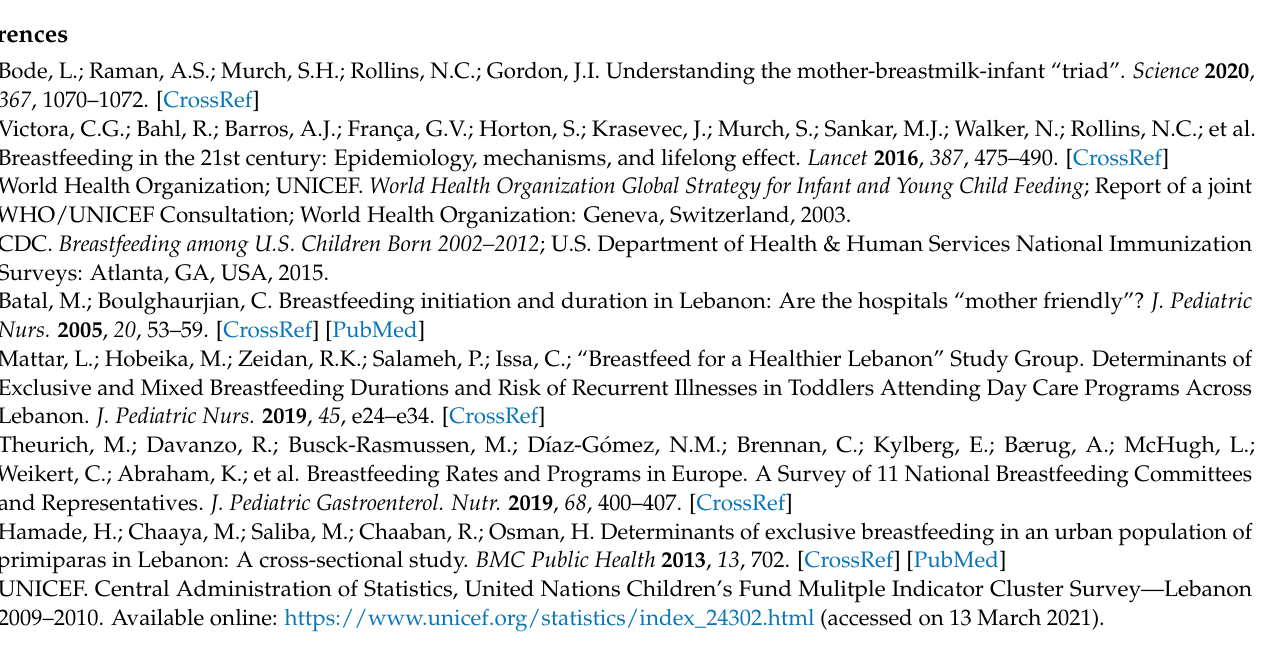
of questions used in employees’ interviews, Figure S1: Conceptual framework, Figure S2: Coding tree—employees, Figure S3: Coding